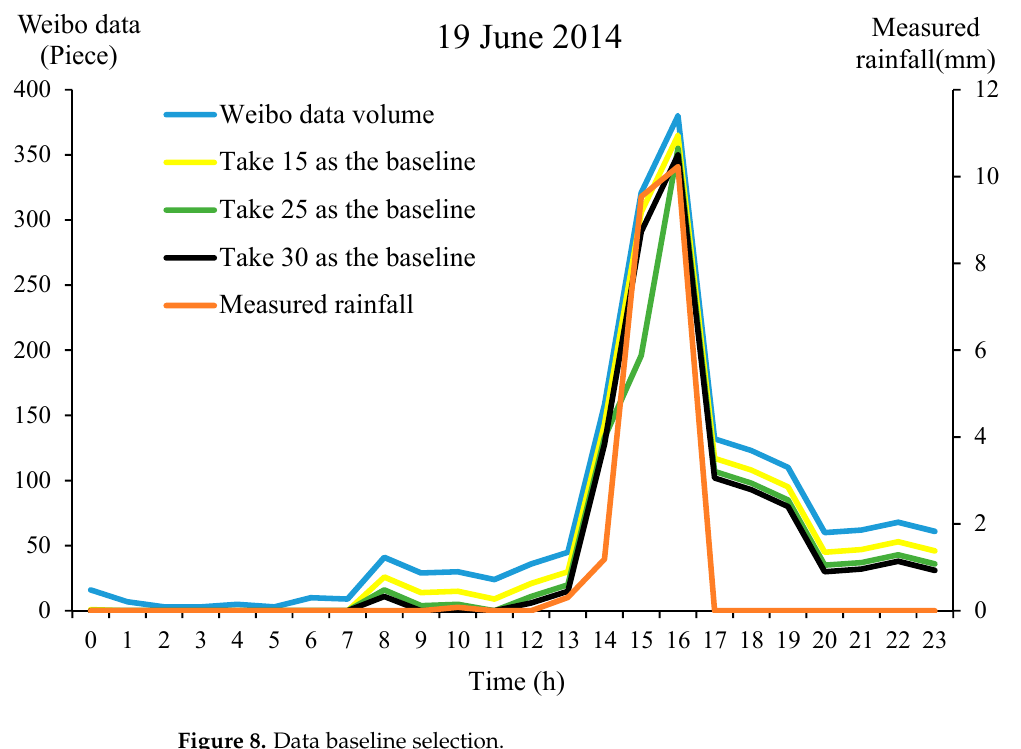
Figure 8. Data baseline selection.